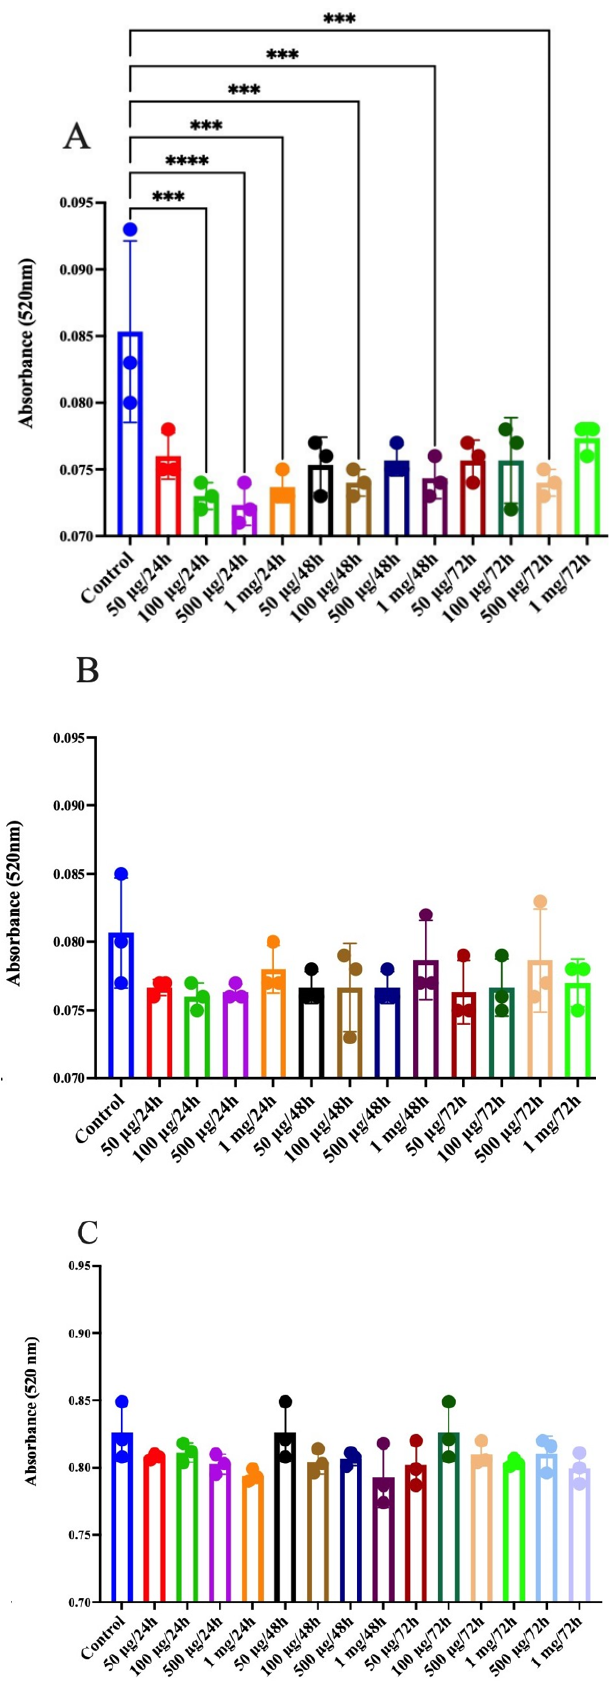
Figure 6. Catalase assay, ( A ) CRL1831, ( B ) HT29, ( C ) SW480. (*** p < 0.005, **** p <